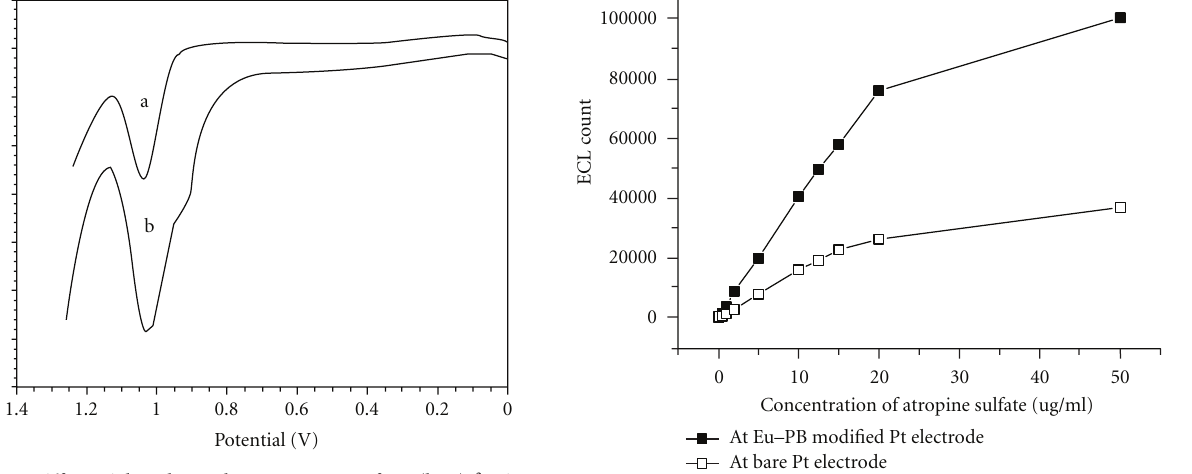
Figure 3: Luminescence response of atropine sulfate at bare Pt elec- trode and at Eu-PB modified electrode: separation capillary: 25 μ m, i.d., 45cm length; sample injection: 10 s at 10 kV; separation voltage: 17kV; running bu ff er: 10mM sodium phosphate, concentration in detection cell: 80 mM, all at pH